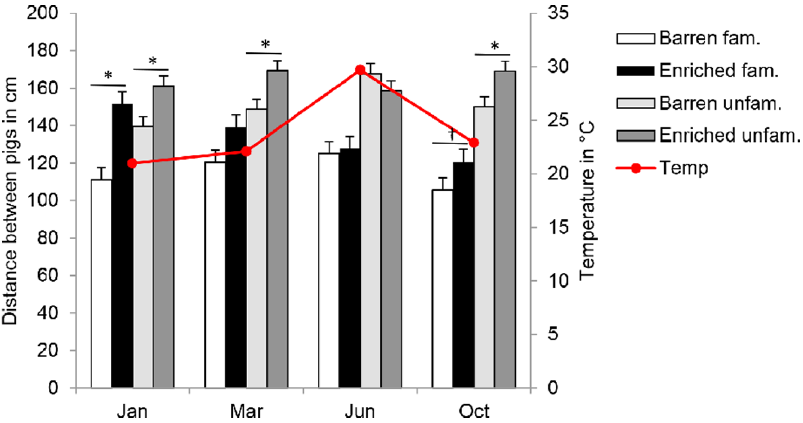
Figure 4. Larger distances in enriched housing conditions. Distances between familiar and unfamiliar pigs in barren and enriched pens, presented by the month in which regrouping took place (batch). The secondary axes shows the maximum temperature in the barn at the day of